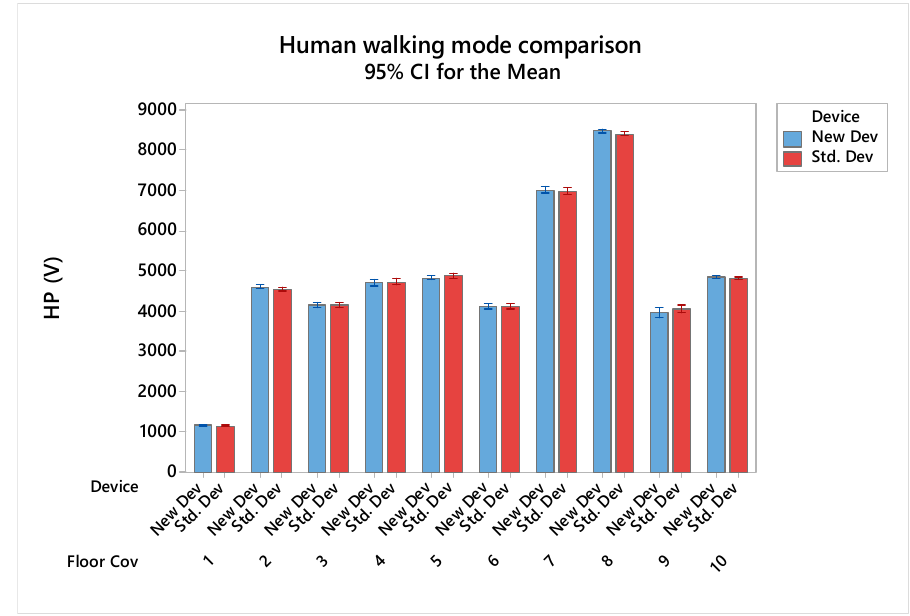
Figure 8. Highest peaks (V) with quality of floorcoverings and platform (New, Std.) as X variable to show the difference of means and standard deviation as interval. Table 3. Univariate analysis results for highest valleys, dependent variable: highest valleys (HV).